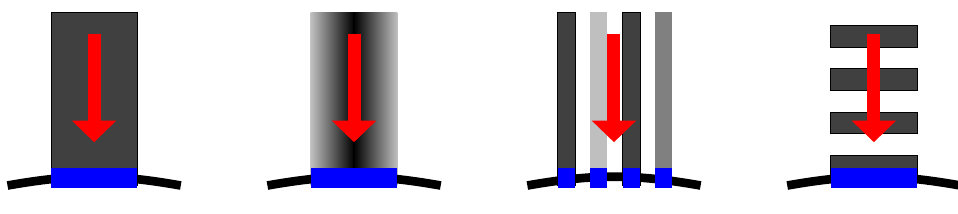
Figure 5. Schematic sketch of scenarios proposed for the structure of accretion columns. The stellar surface is at the bottom and material flows along a magnetic field line onto the stellar surface (indicated by the red arrow). The accretion shock (blue) forms on the stellar surface. Density is shown as gray scale. From left to right: (1) One homogeneous column with one density and a single infall velocity; (2) one column with a density stratification (high density in the center of the column indicated by the black region, lower density in the outer region indicated by the grayish color) and one infall velocity; (3) multiple columns that are individually homogeneous, i.e., have different densities but are otherwise equal; (4) one “column” is decomposed into individual blobs that are, individually, homogeneous in